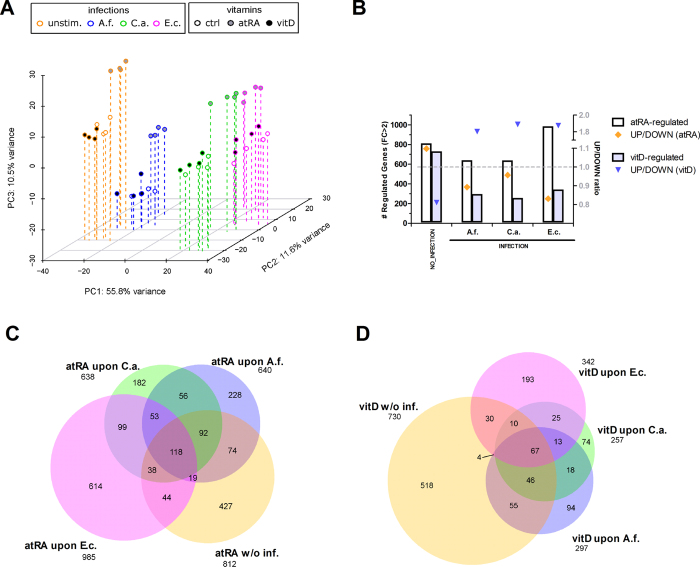
Bird’s eye view of transcriptome changes upon stimulation with vitamin during infection.Our results demonstrate a huge impact of the pathogens and vitamins on the transcriptional landscape of human monocytes. Furthermore, the transcriptional regulation by the vitamins is dependent on the pathogenic stimulus. (A) 3-dimensional Principal Component Analysis (3D-PCA) of the top 300 most variant genes was plotted with the scatterplot3d package in R67. The first three principal components (PC1-PC3) account for 78% of the total variance of the data. (B) Representation of the total number of genes as bars (left Y-axis) and the ratio of up-/down-regulated genes as diamonds and triangles (right Y-axis) in response to atRA and vitD during all stimulatory settings. (C) Venn diagram showing the overlap of the atRA-regulated genes (FC > 2, p < 0.05) during A. fumigatus stimulation (A.f., blue), C. albicans stimulation (C.a., green), E. coli stimulation (E.c., magenta) or in absence of pathogen stimulation (w/o inf., orange). (D) Venn diagram showing the overlap of the vitD-regulated genes (FC > 2, p < 0.05) during A. fumigatus stimulation (A.f., blue), C. albicans stimulation (C.a., green), E. coli stimulation (E.c., magenta) or in absence of pathogen stimulation (w/o inf., orange).